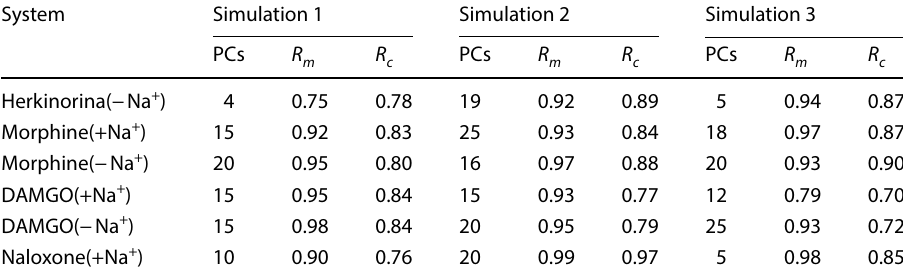
Table 2 The number of principal components (PCs) implemented for building functional mode analysis (FMA) for each